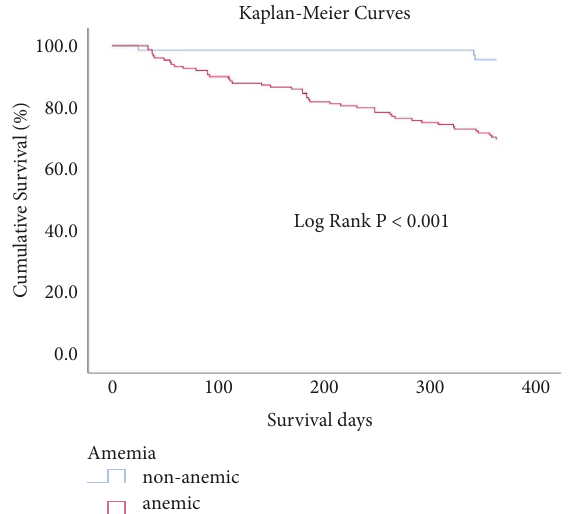
Figure 2: Kaplan–Meier curves for LRTI-related mortality within 1 year of